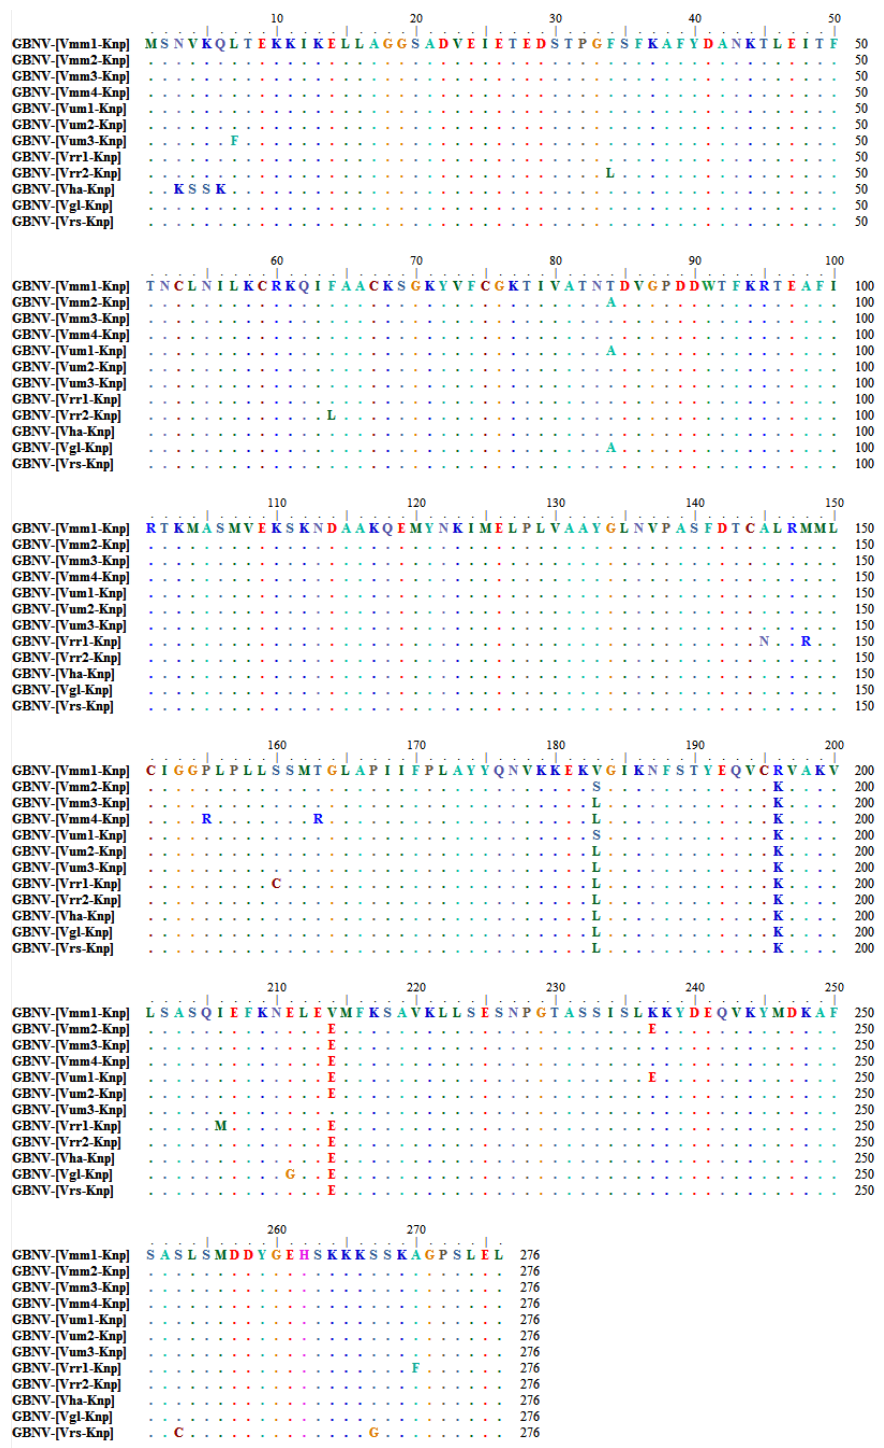
Figure 3. Multiple alignments of NP gene sequences of GBNV isolates collected from one field. Dot indicates identical amino